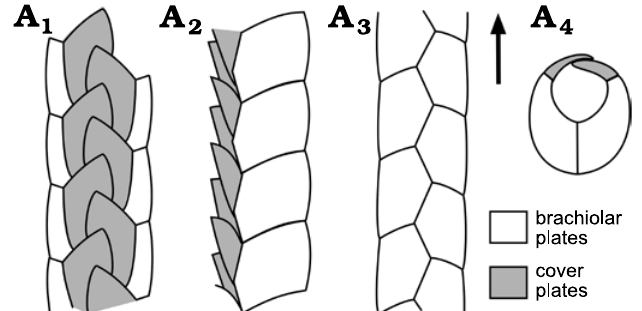
Fig. 2. Growth zone as seen in a brachiole of the early Cambrian blasto- zoan, Kinzercystis durhami Sprinkle, 1973, early Cambrian, Pennsylvania, USA. The brachiole consists of a central alternating pair of columns of floor (brachiolar) plates, with a single series of cover plates along each lateral margin. Plates are added at the distal tip according to the ocular plate rule. Ventral (A 1 ), right lateral (A 2 ), and dorsal (A 3 ) views; cross sec- tion (A 4 ). Arrow indicates growth direction. Redrawn and simplified from Sprinkle 1973: 16, fig.